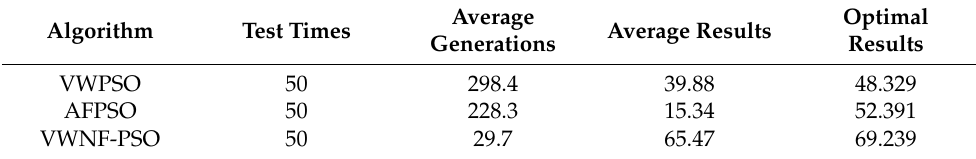
Table 11. Algorithm contrast.